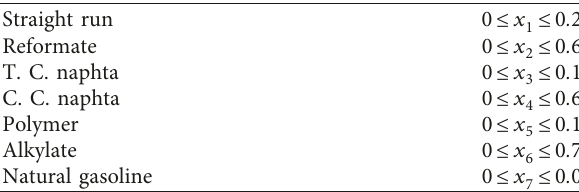
Table 1: Chemical components of octane